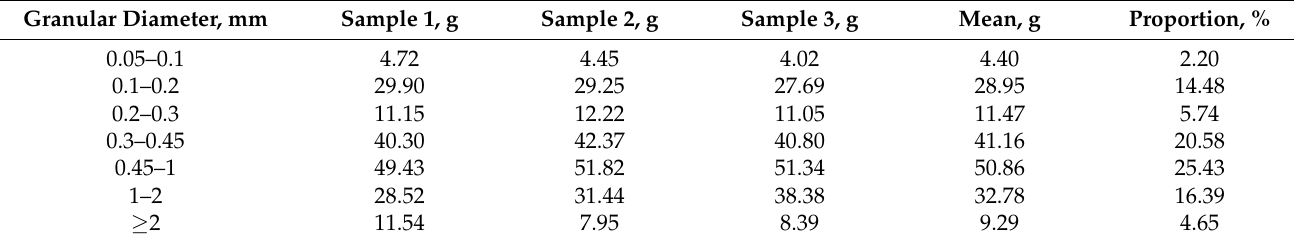
Table 1. The particle size distribution in the soils.